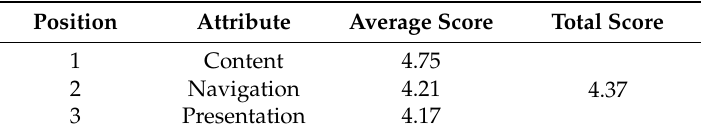
Table 9. Results of Instrument 3, nutritionist